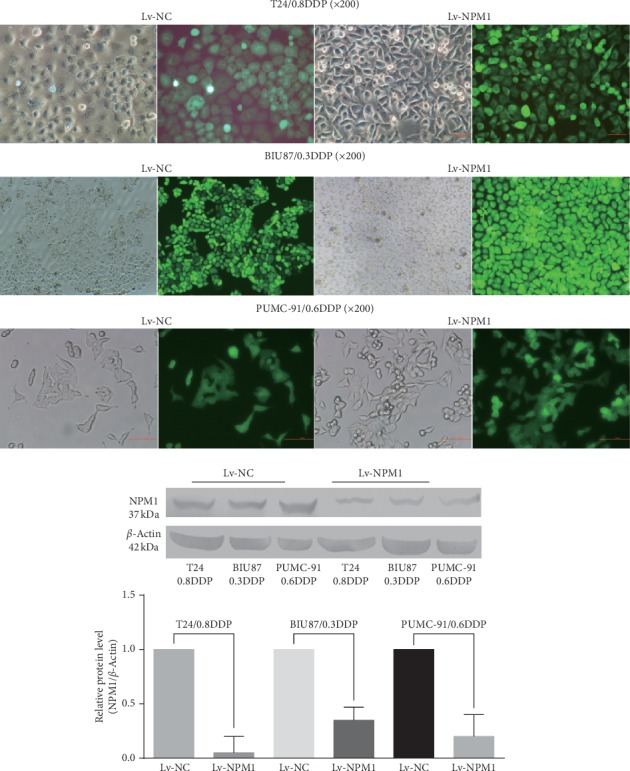
The stable NPM1 silencing cell lines (T24/0.8DDP Lv-NPM1, BIU-87/0.3DDP Lv-NPM1, and PUMC-91/0.6DDP Lv-NPM1) and the corresponding negative control cell lines (T24/0.8DDP Lv-NC, BIU-87/0.3DDP Lv-NC, and PUMC-91/0.6DDP Lv-NC).